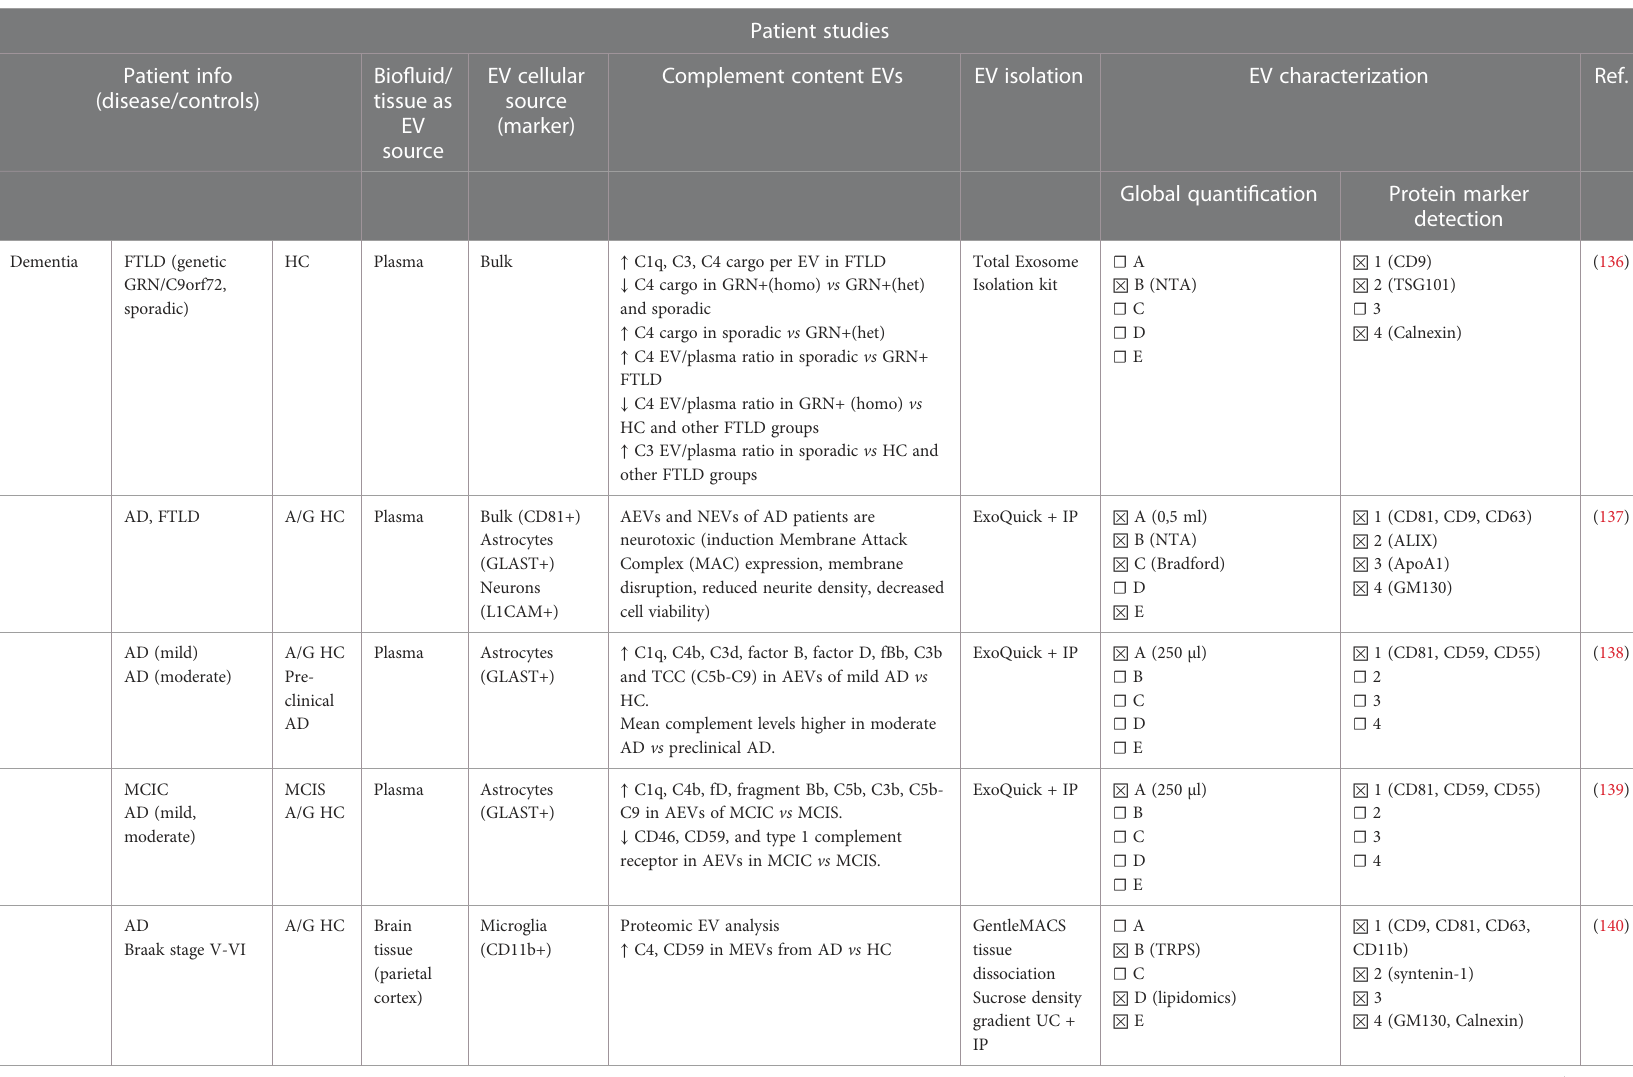
TABLE 5 Minimal Information for Studies of EVs (MISEV) guidelines related information about EV isolation and characterization in the studies discussed in this review, investigating human- and mouse-derived